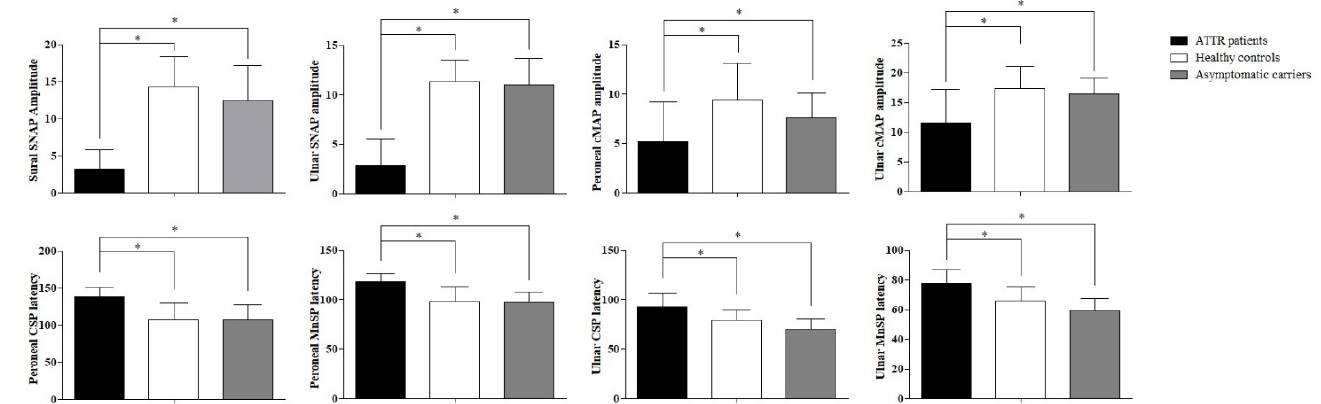
Figure 1. Neurophysiologic differences between the three groups. * p < 0.05.